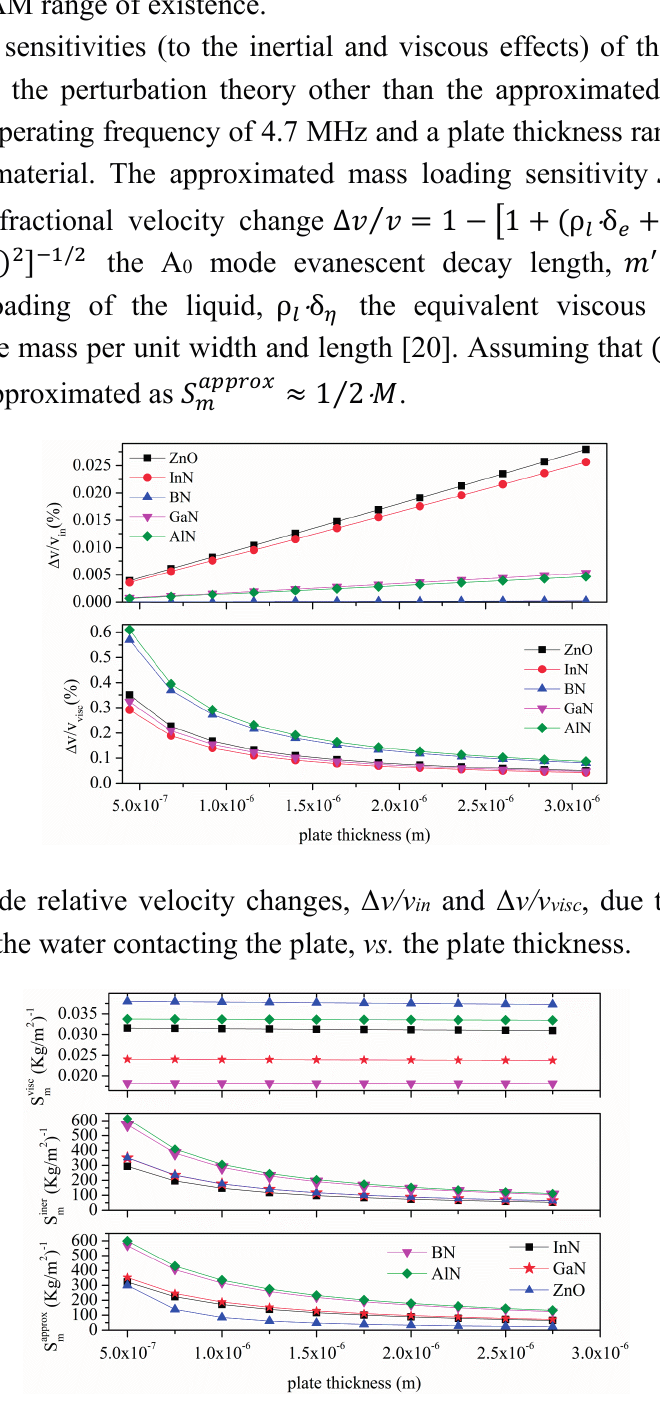
Figure 15. Inertial effect sensitivity ( (cid:1845) (cid:3040)(cid:3036)(cid:3041)(cid:3032)(cid:3045) ), viscous effect sensitivity ( (cid:1845) (cid:3040)(cid:3049)(cid:3036)(cid:3046)(cid:3030) ) and approximated sensitivity ( (cid:1845) (cid:3040)(cid:3028)(cid:3043)(cid:3043)(cid:3045)(cid:3042)(cid:3051) ) for the A 0 mode vs. plate thickness due to the loading of a viscous liquid